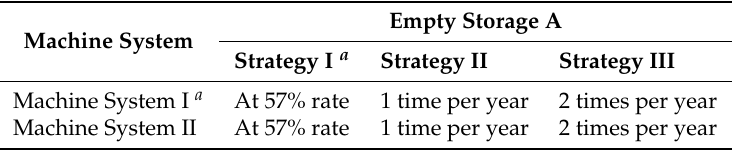
Table 1. Tested combinations of machine systems and inventory management strategies for emptying storage area